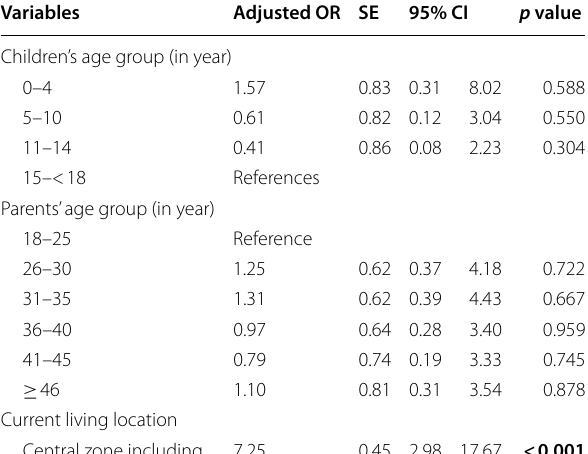
Table 2 Multiple logistic regression: predictors of parental vaccine hesitancy in study participants